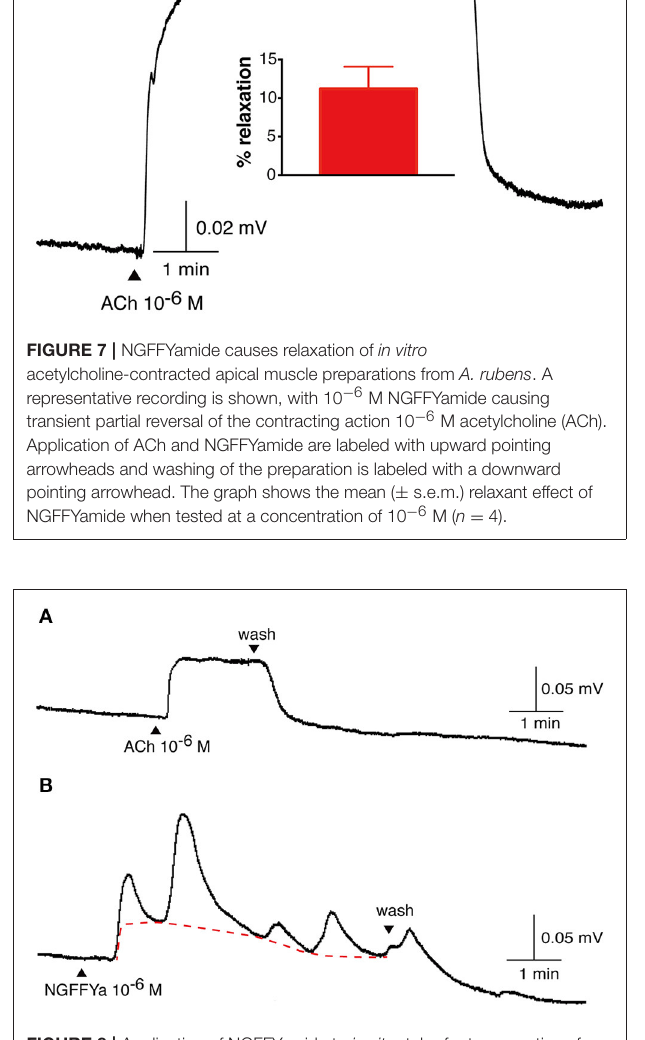
< 0.05). NGFFYamide treatment did not affect the maximum acceleration (10.1 ± 4.4 cm/s 2 for control-and 5.7 ±